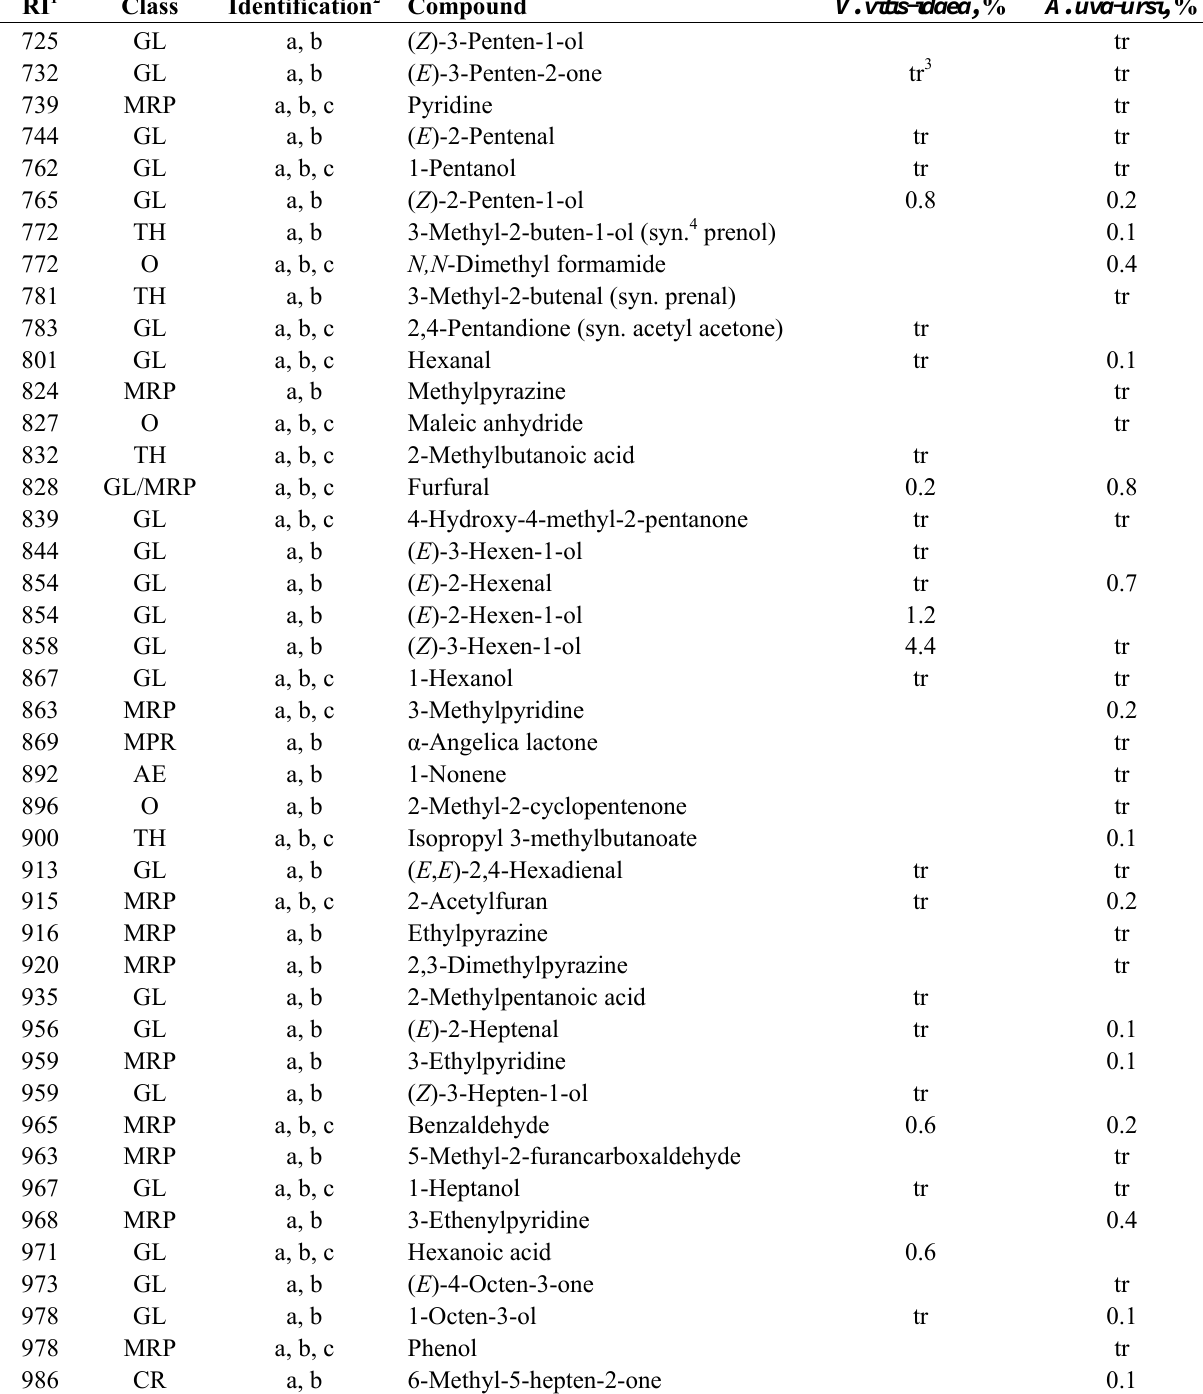
Table 1. Chemical composition of the essential oils extracted from the leaves of Arctostaphylos uva-ursi and Vaccinium vitis-idaea